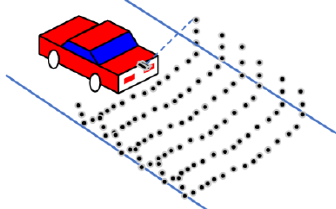
Figure 1 : scan-line obtained by MLS acquisition after Yao et